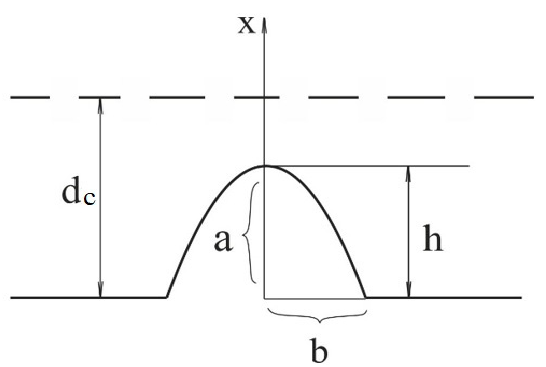
Figure 5. Scheme of a semi-elliptical protrusion on the surface of a flat cathode: a, b are the semi axes of the ellipsoid; h—the height of the protrusion; dc—the length of the cathodic potential drop region.